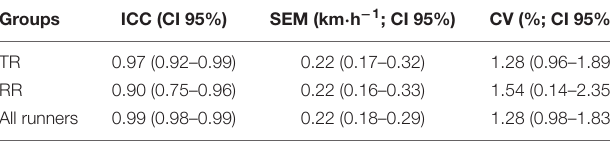
Note: TR, trained runners; RR, recreational runners; ICC, intraclass correlation coefficient; SEM, standard error of measurement; CV, coefficient of variation; CI, confidence